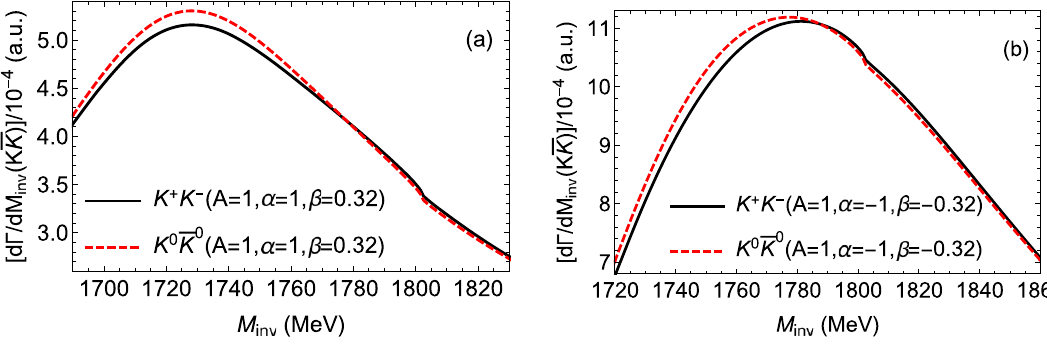
Fig. 8 Differential decays for the reactions J /ψ → φ K + K − ( K 0 ¯ K 0 ) , taking distinct